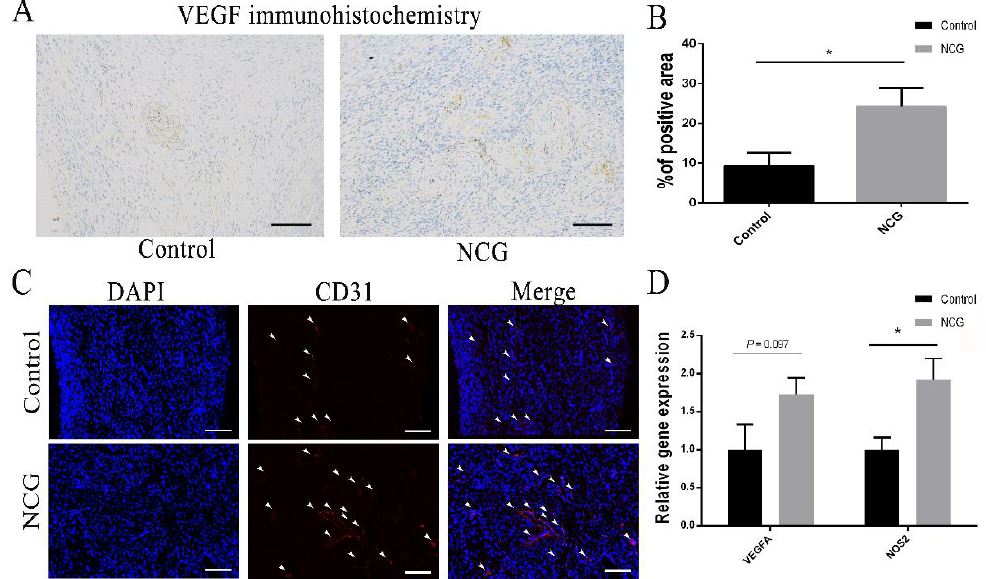
Figure 5. Effects of NCG on angiogenesis in yak ovaries. ( A ) Immunohistochemistry (IHC) to detect vascular endothelial growth factor (VEGF) in the ovaries. Scale bar: 50 μm. ( B ) Percentage of area positive for VEGF in the ovaries was calculated using Image-Pro Plus software. ( C ) Immunofluo-